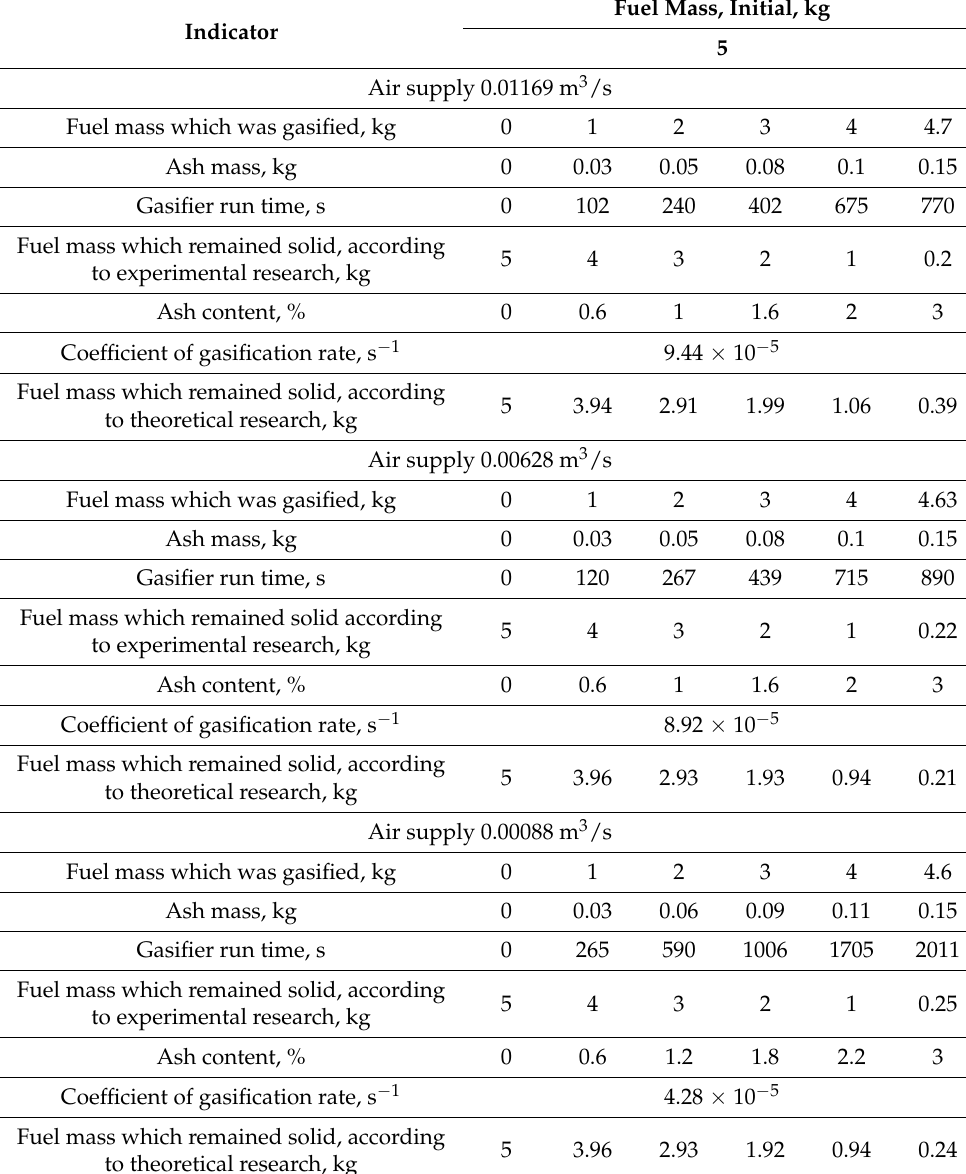
Table 1. Indicators of theoretical and experimental studies of the gasification rate of wood pellets.